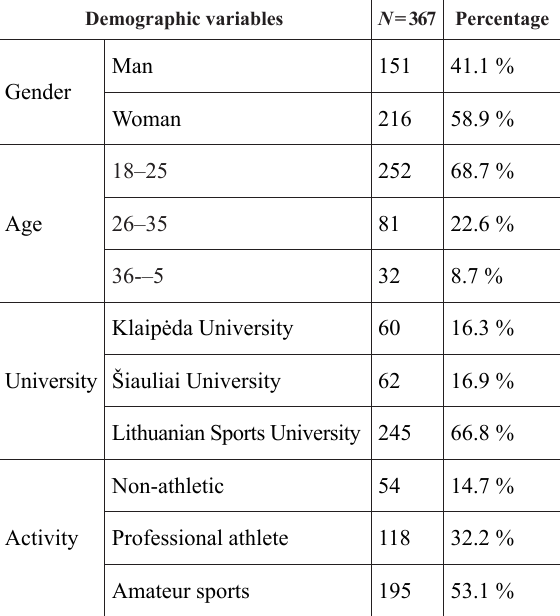
Table 1. Demographic characteristics of